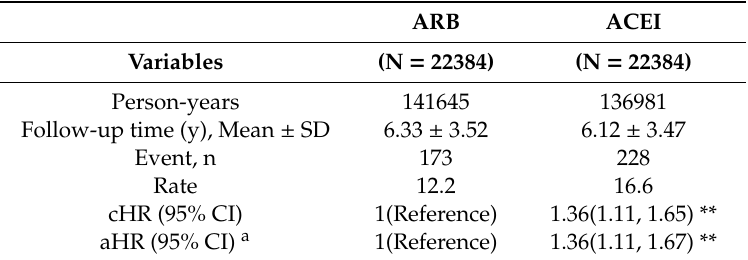
Table 2. Cox analysis of overall incidence of lung cancer (per 10,000 person-years) and estimated hazard ratios according to medication status.